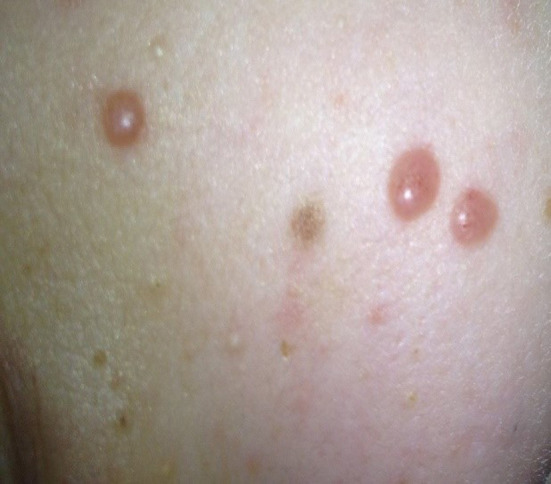
Multiple papulonodular skin lesions with predilection for cheeks.